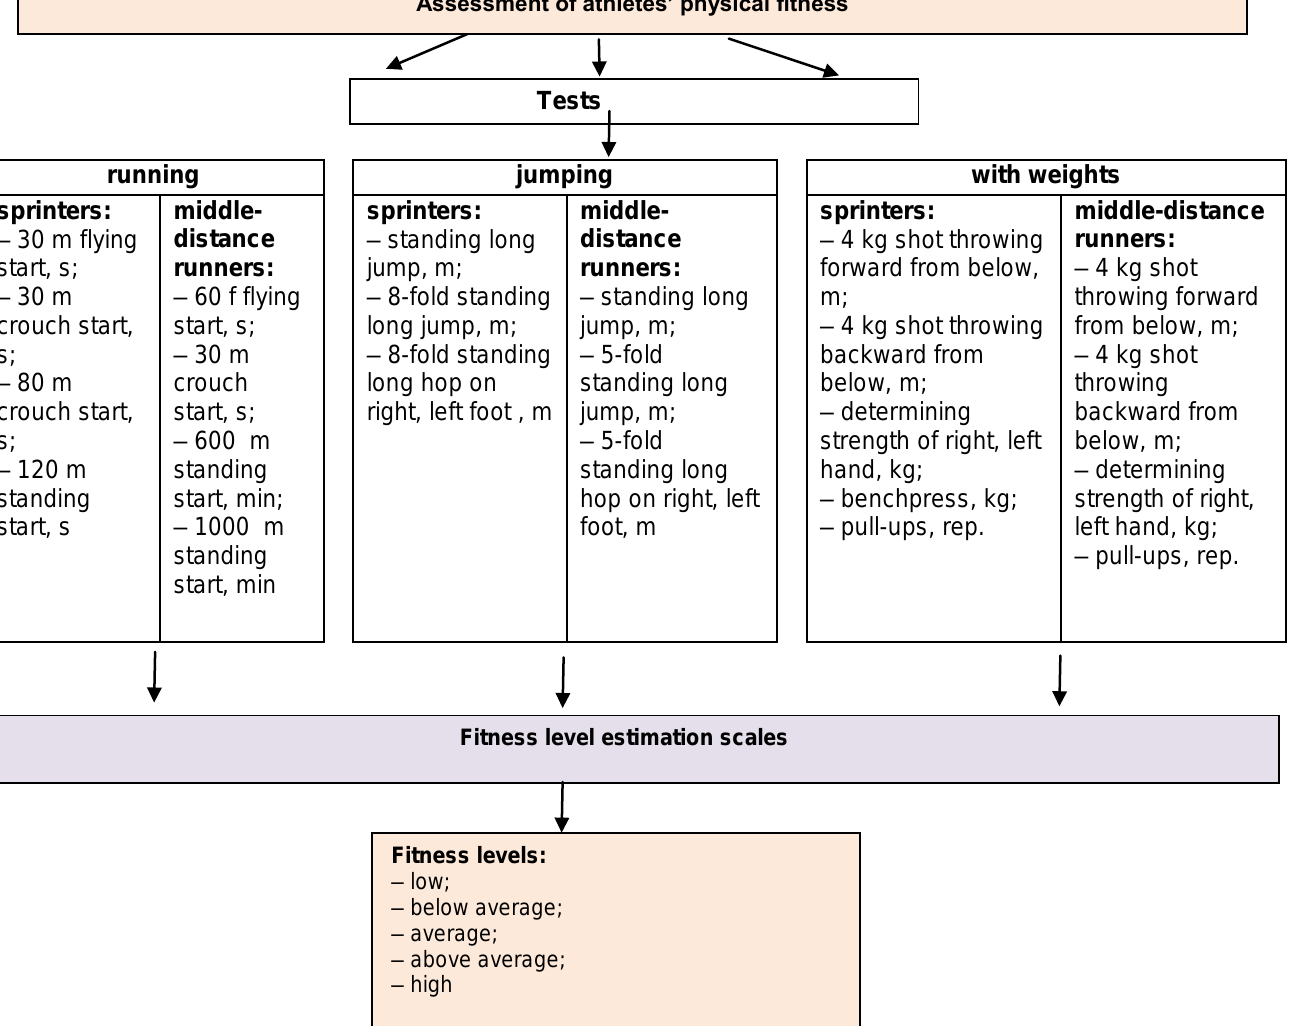
Fig. 4. Diagram of the methods of estimating physical fitness of skilled track and field athletes (on the example of sprinters and middle-distance